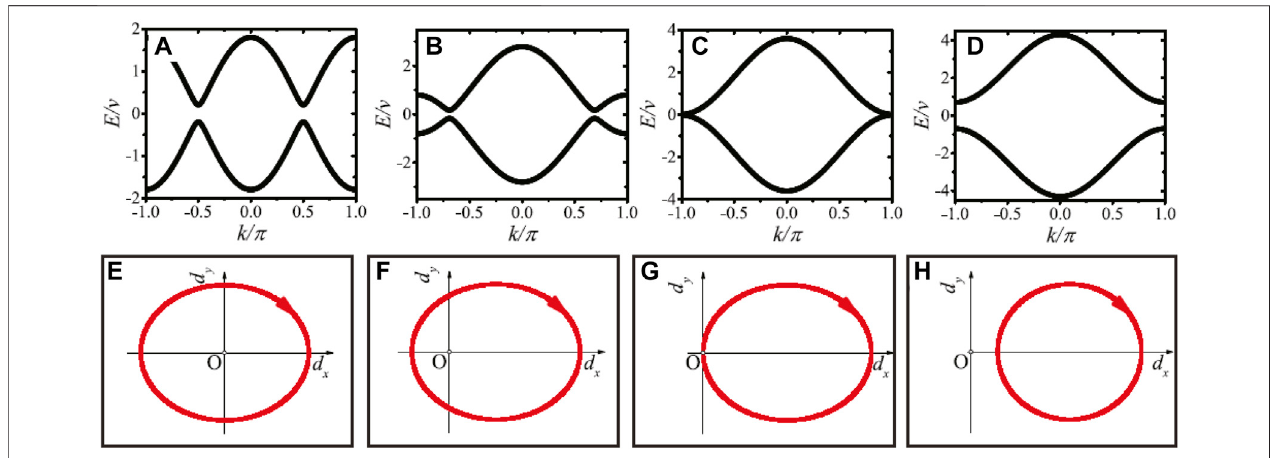
FIGURE 3 | (Color online) Dispersion relations of the generalized SSH model with different hopping amplitude J : (A) J (cid:1) 0; (B) J / v (cid:1) 1; (C) J / v (cid:1) 1.8; (D) J / v (cid:1) 2.5. (E – H) The paths ofthe endpoint of the vector d ( k ) corresponding to (A – D) are shown on the d x , d y plane as the wavenumber is sweeped across the Brillouin zone, k (cid:1) 0 → 2 π . The other parameters are z / v (cid:1) 0.8 and ϕ (cid:1) 0.